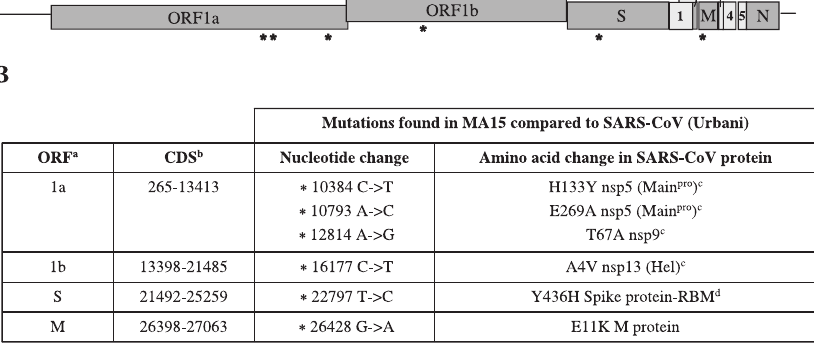
Table 1. Mice receiving a dose (cid:2) 10 3.9 TCID 50 of MA15 virus